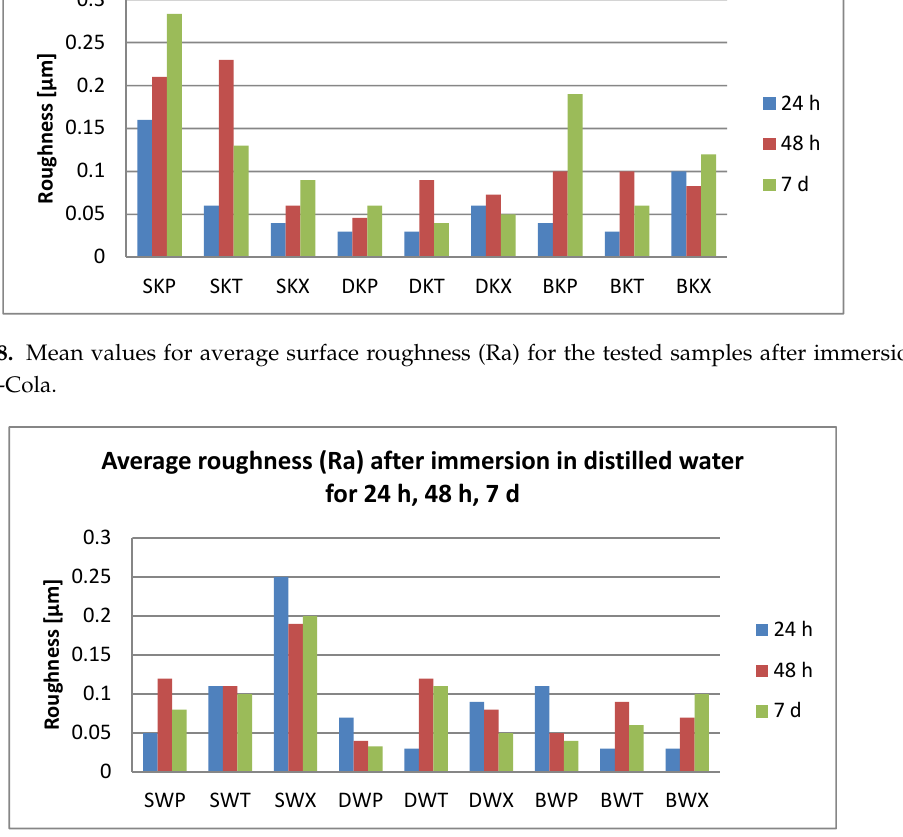
Figure 9. Mean values for average surface roughness (Ra) for the tested samples after immersion in distilled water.